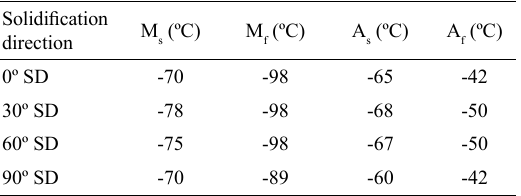
Table 1. Temperatures of phase transformations as a function of solidification direction.